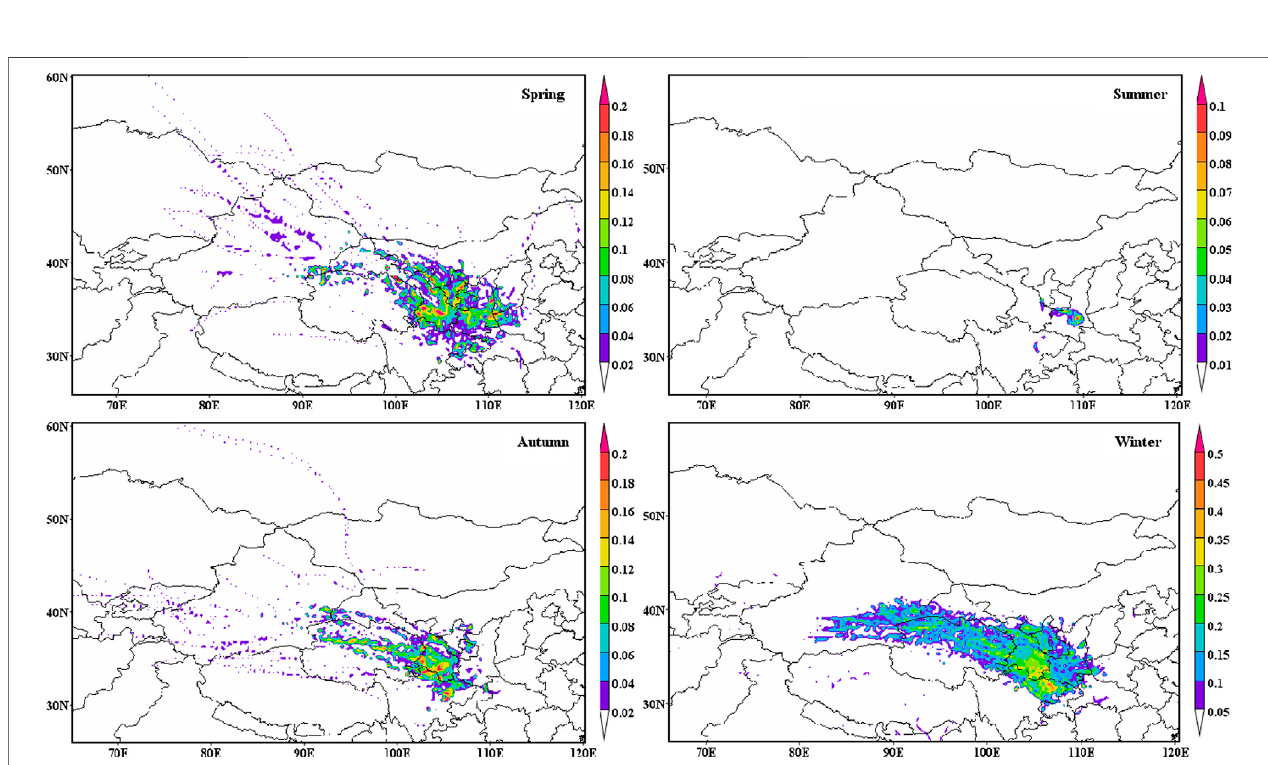
FIGURE 8 | Weighted potential source contribution function distribution of PM 10 in different seasons.